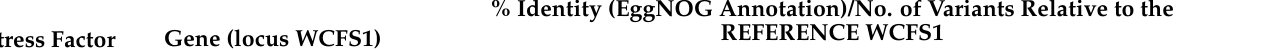
Table 3. List of genes and annotated variants associated with bacterial adaptation to different stressors in specific